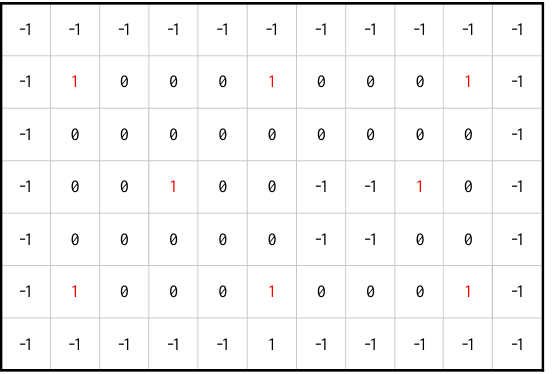
Figure 10. Initial Placement Solution generation